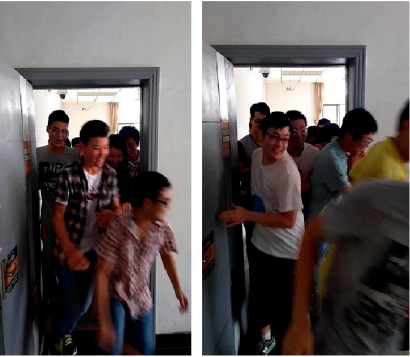
Figure 28. Screenshot of outlet flow experiment.